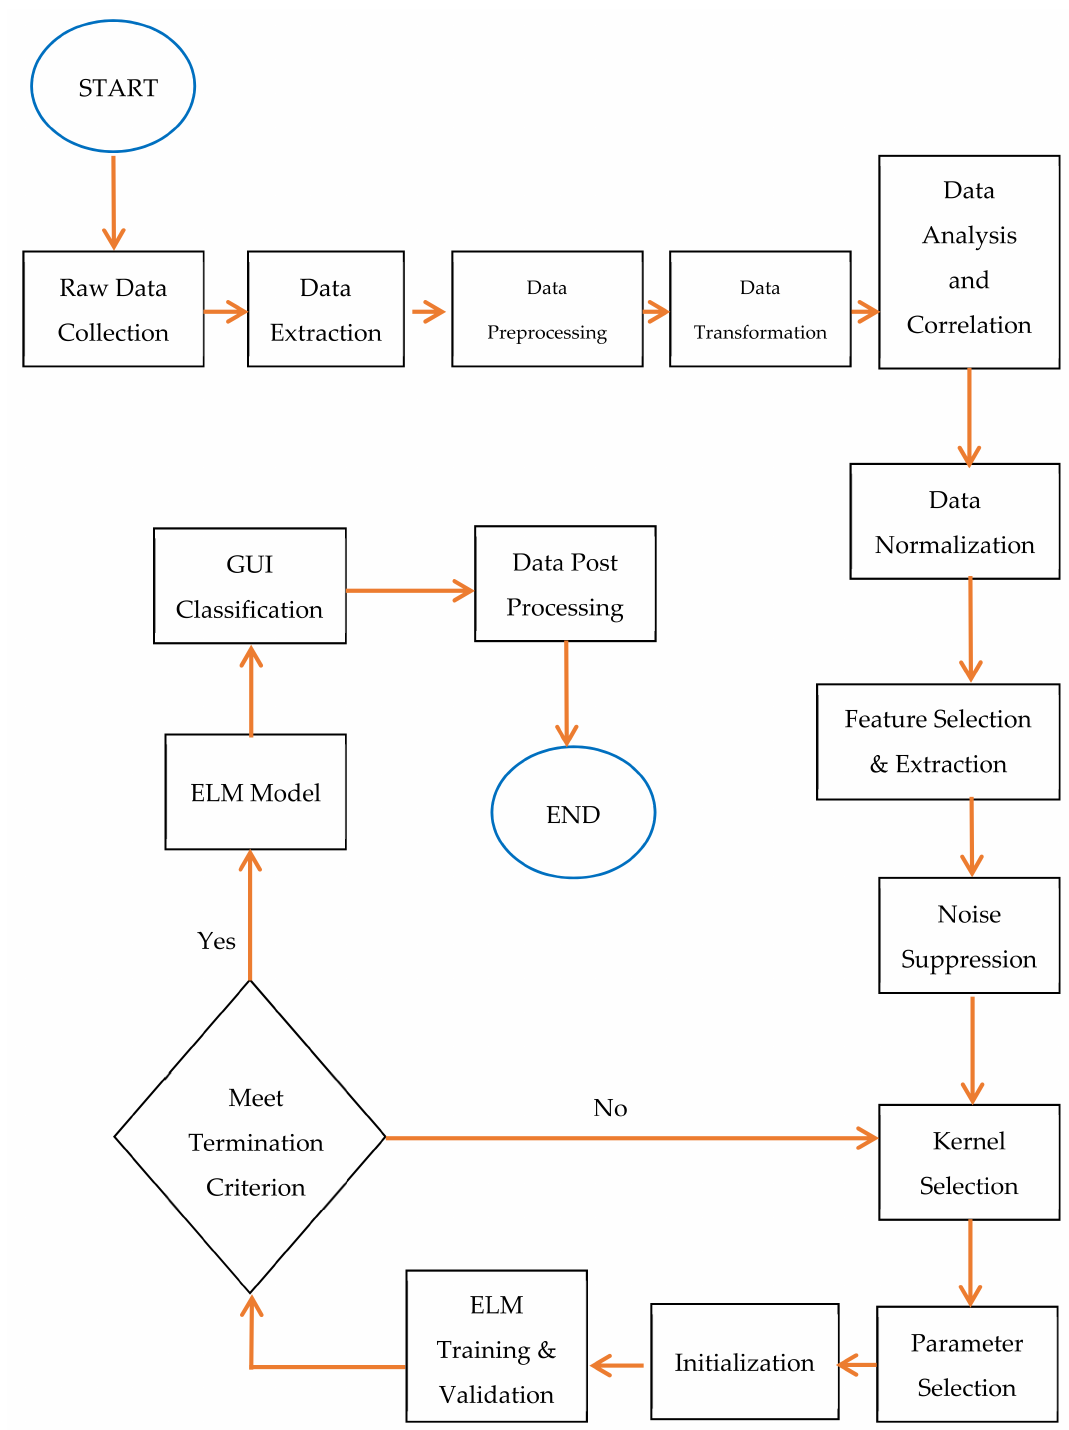
Figure 3. Flowchart diagram of the research